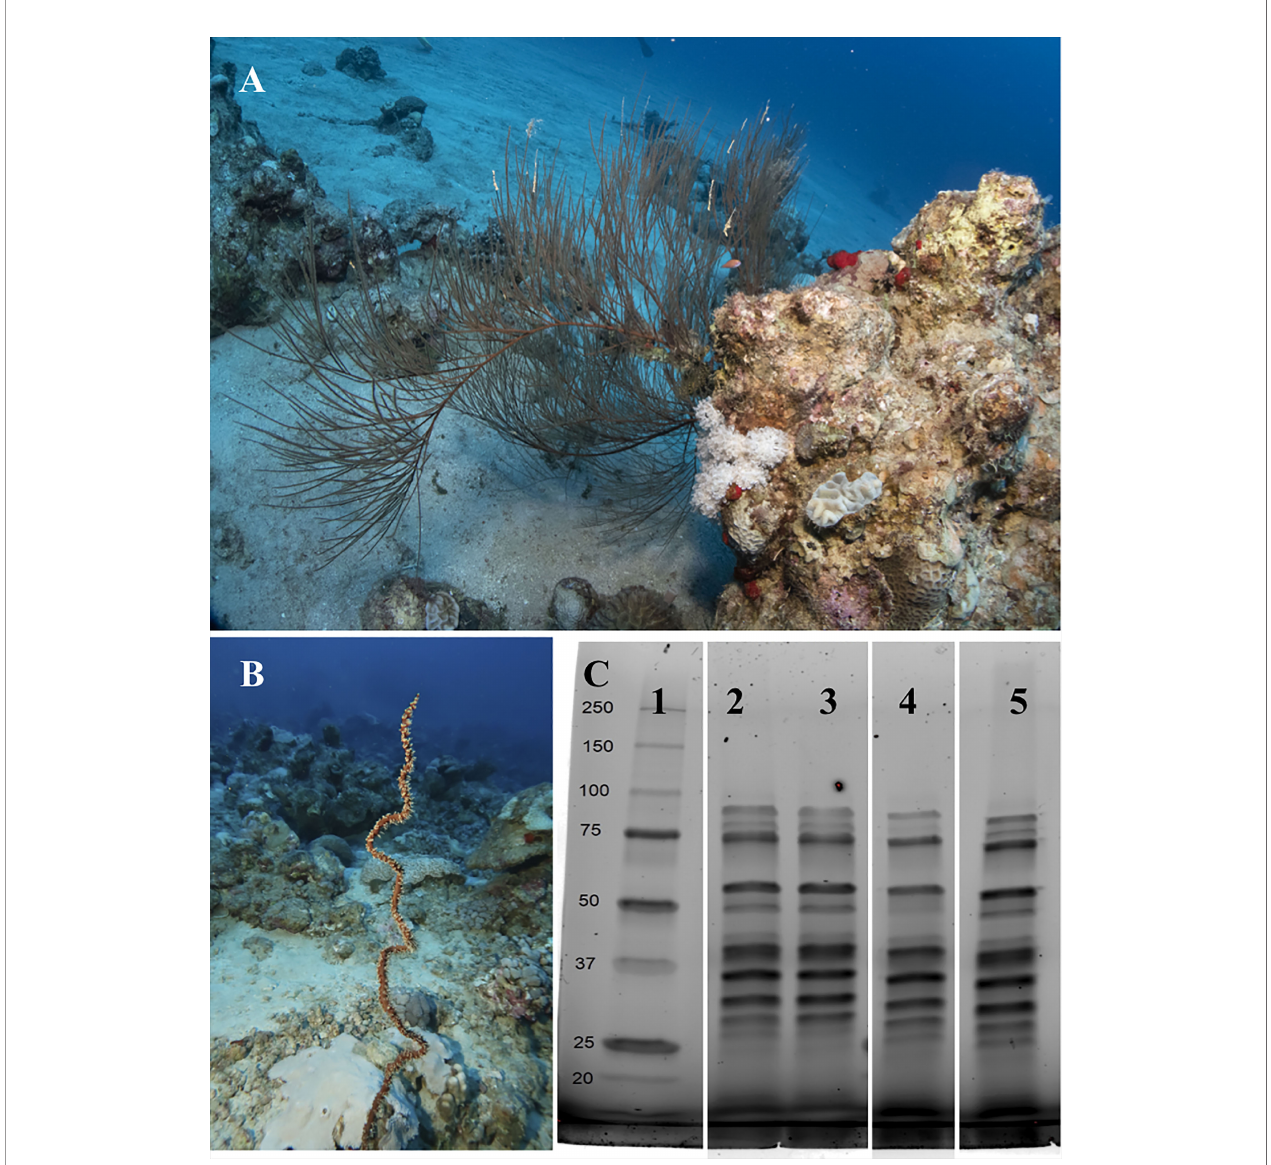
FIGURE 1 | Antipathes griggi (A) and Stichopathes sp. (B) collected from the Red Sea adjacent to the Interuniversity Institute in Eilat, Israel, at 40-60 m depth, for proteomic sequencing of the chitinous skeleton. (C) Imaging of SDS-PAGE separation of proteins extracted by chitinase from chitinous black coral skeleton cleaned both before and after grinding. MW marker (lane 1); Antipathes cleaned only before grinding (lane 2); Stichopathes cleaned only before grinding (lane 3); Antipathes cleaned before and after grinding (lane 4); Stichopathes cleaned before and after grinding (lane 5). Photos: Hagai